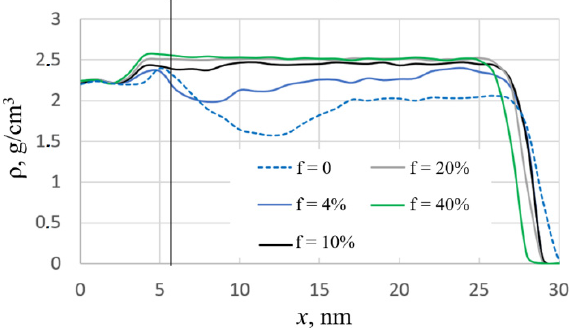
Figure 2. Density profiles of the deposited films: x is the coordinate of the film perpendicular to the substrate surface, x = 0 corresponds to the lower edge of the substrate, f is the fraction of assisting ions. The vertical line is the boundary between the substrate and the film, and energy of assisting ions E = 100 eV.